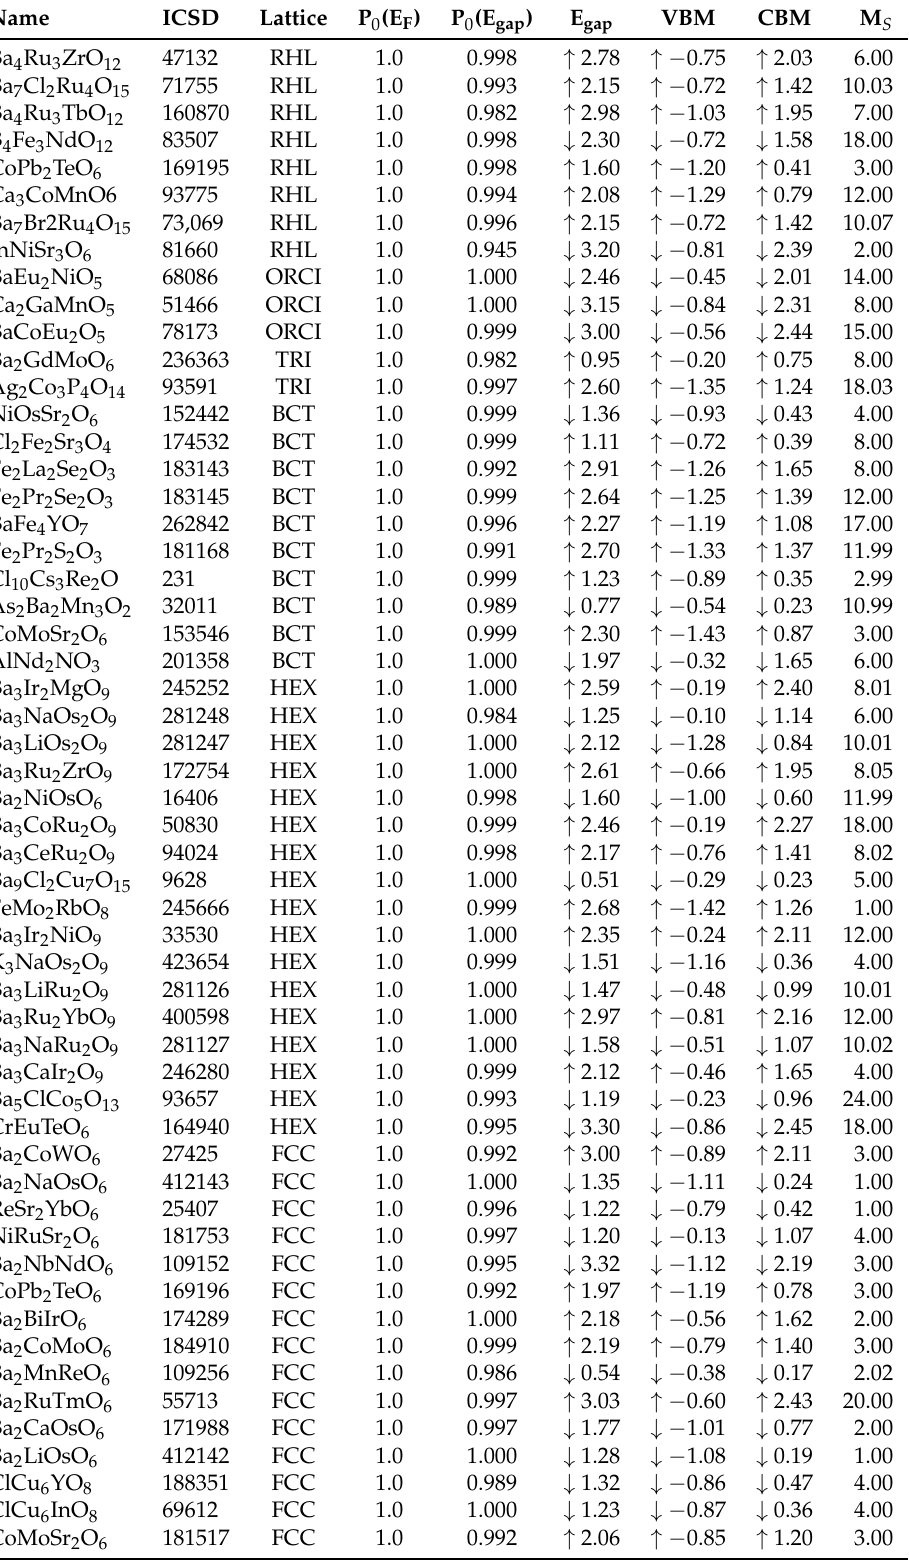
Table A3. Quaternary half-metallic oxides. Parameters are the same as in Table